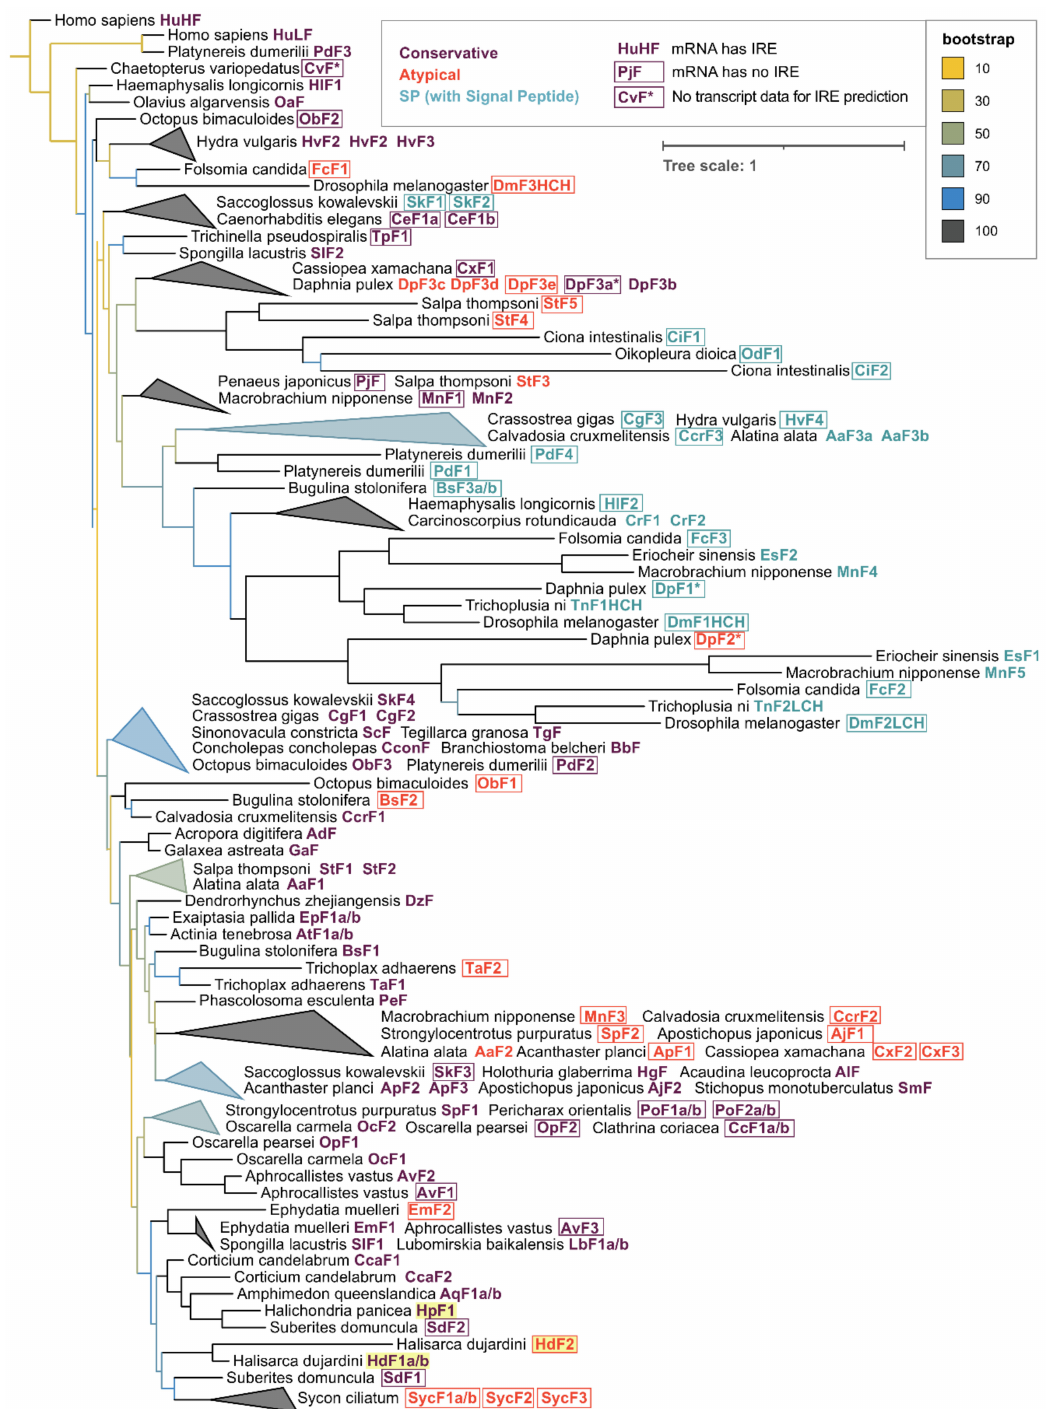
Figure 5. Phylogenetic tree of invertebrate and human ferritins. 131 representative ferritins from 56 species of 32 invertebrate classes (Supplementary Table S1) along with human ferritins were aligned using clustalo algorithm [43], the alignment was processed with Gappyout algorithm using trimal v. 1.2 software [44] to remove variable ends and regions of signal peptide (132 core residues left). The tree was constructed using the Maximum likelihood approach with 1000 fast bootstrap resamplings with IQ-Tree v. 1.6.12 [45] and visualized using iTOL server [46], with ferritin sequences of Homo sapiens used as an outgroup. Triangles represent collapsed clades with upper and lower points showing the range of branch lengths inside a clade. The full version of this tree without collapsed branches is shown in Supplementary Figure